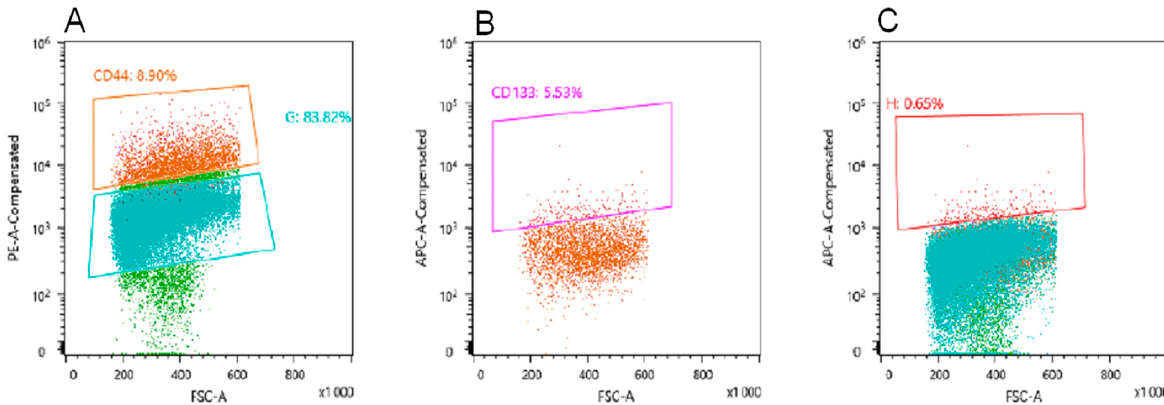
Figure 2. Evaluation of CSCs markers CD44 and CD133 using FACS-analysis. ( A )—population of cells, positive for CD44 (orange); ( B )—population of CD44-positive cells with a population of CD133-positive cells detected in it (pink); ( C )—population of cells positive for the marker CD133 (red).